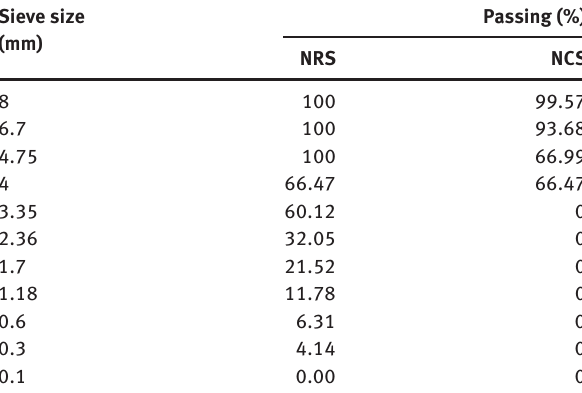
Table 3: Size distributions of